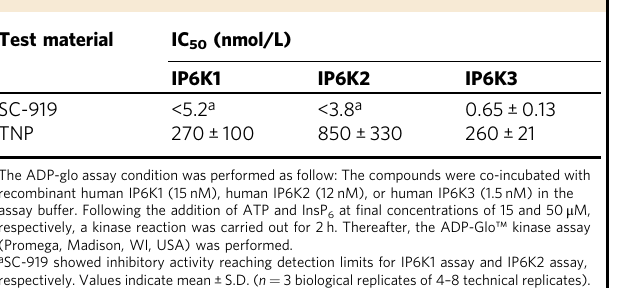
Table 2 In vitro plasma protein binding ratios of SC-919 in rats, monkeys, and